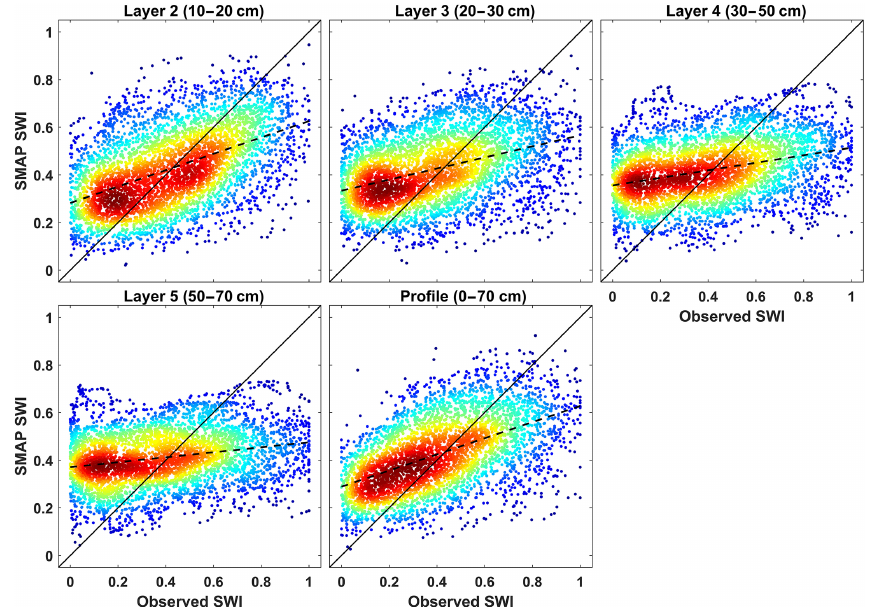
Figure 7. Comparisons of SMAP_L3 estimated–observed subsurface SWI for all stations during the growing seasons of 2015 to 2016. The smoothed color density in the scatter plot shows the density of points more clearly. The dash and solid lines are the best-fitted curve and “ y = x ” line, respectively. Table 5. Performance metrics (RSR, R , NSE) for the comparison of SMAP estimated and observed SWI at different layers for the 35 stations during the growing seasons of 2015 to 2016. Layer RSR R NSE Mean ± SD Median Mean ± SD Median Mean ± SD Median Layer 2 a 1 . 24 ± 1 . 31 0.92 0 . 58 ± 0 . 28 1 . 28 ± 0 . 83